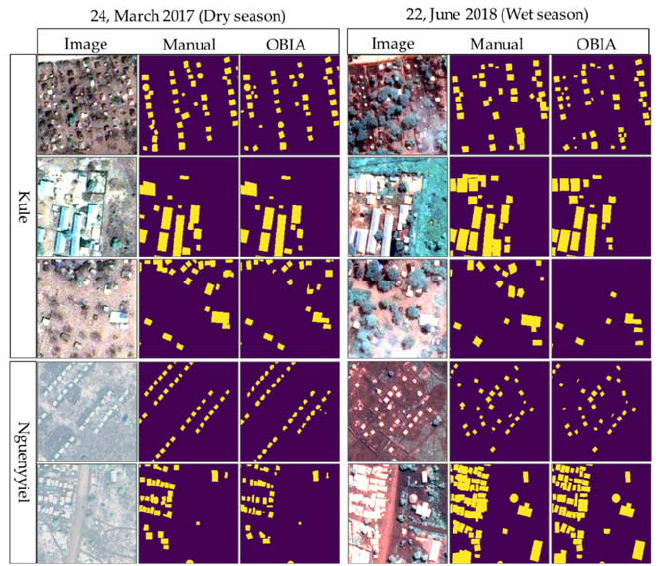
Figure 3. The examples of the OBIA labels and the Manual labels of built-up structures in the Kule and Nguenyyiel refugee camps during the dry and the wet seasons.